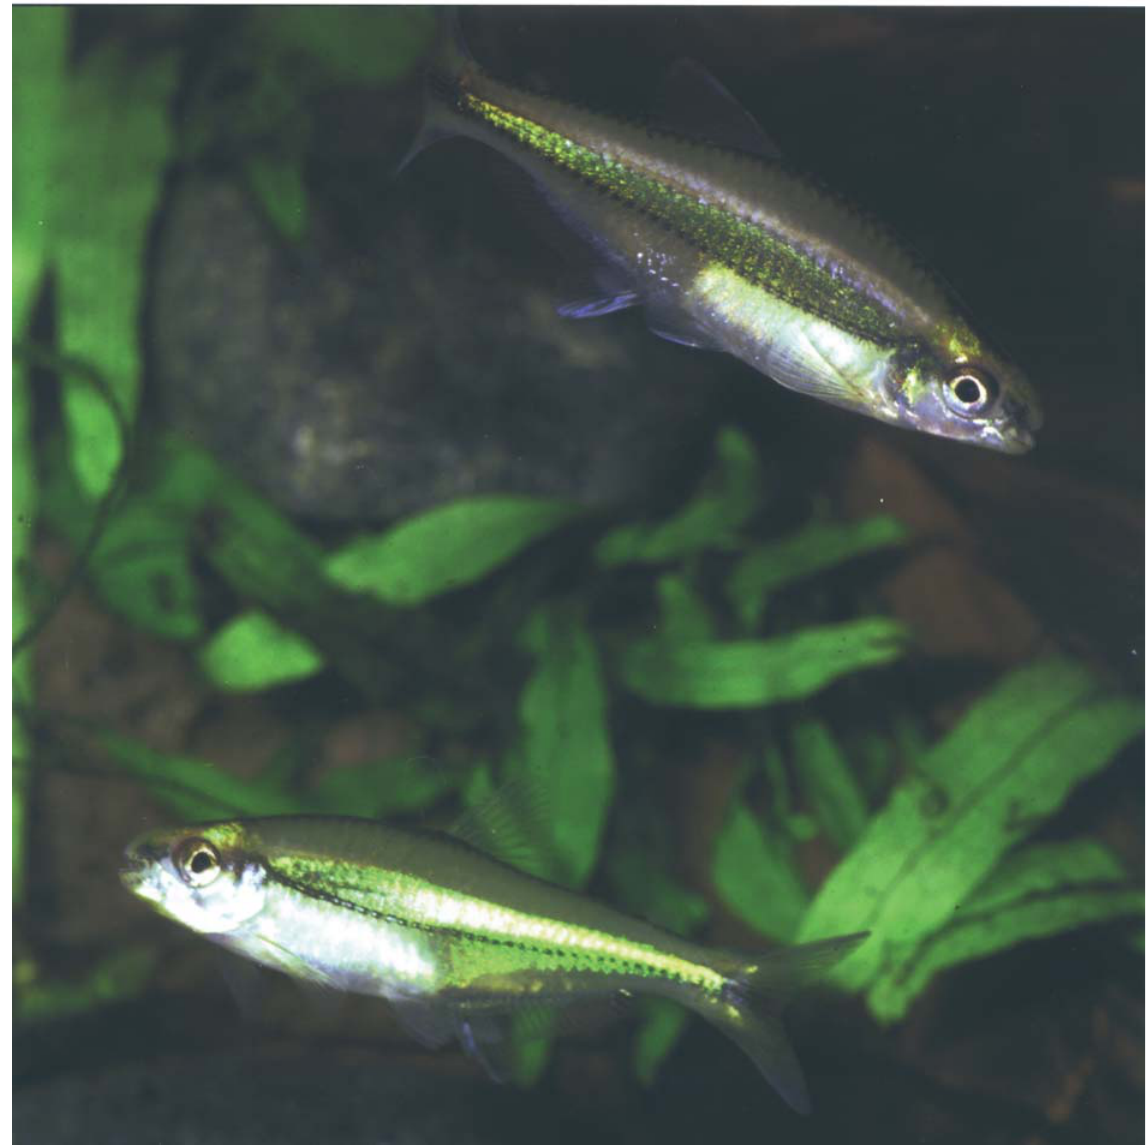
Fig. 1. Bryconadenos tanaothoros , two live adult male specimens in aquaria. Originally collected in Brazil: Mato Grosso; tributary to rio Suiazinho near Ribeirão Cascalheira. The reflective green shown especially by the lower specimen of the two sexually active males displays only weakly this color of the body sides. The position of the anal-fin gland can be seen as a pale gray-white oval area just posterior to the proximal end of the white pigment along the anterior border of the anal fin, especially in the upper male in the picture. Both males display the lateral-line pores and tubes outlined in black as occurs in live